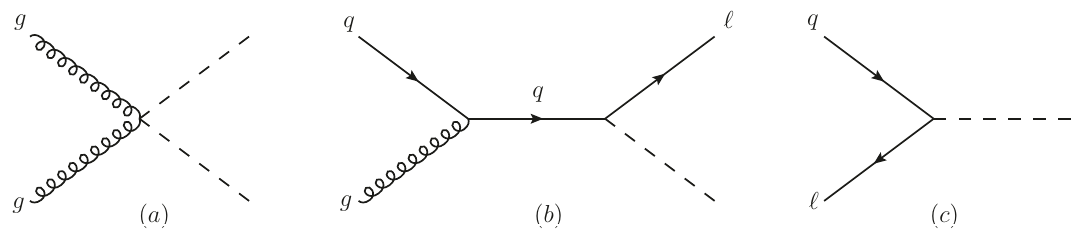
Figure 1 . Representative Feynman diagrams for three different leptoquark production mechanisms at hadron colliders: ( a ) pair pp → S †